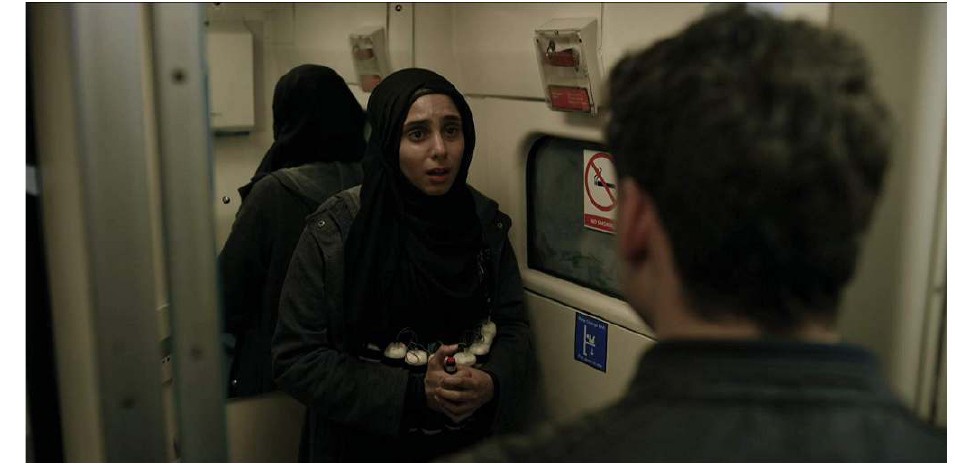
Figure 3. Afghanistan war veteran David Budd (Richard Madden) rescues a train from a hijab - wearing suicide bomber Nadia (Anjli